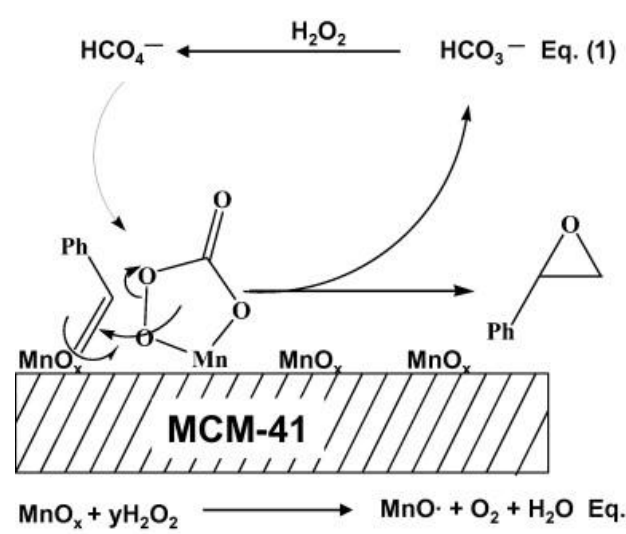
Figure 15. Possible reaction mechanism for the epoxidation of styrene on Mn-MCM-41. Reprinted from Ref. [132], Copyright 2014, with permission from Elsevier. Figure 16. Depiction for the diffusion of styrene inside the pore channels of different catalysts in epoxidation process: ( a ) 3Cu-MCM-41( d ), ( b ) 3CuO/AMS, ( c ) 3Cu-SBA-15(d), ( d ) 3CuO/SBA-15(p), ( e ) 3CuO/AMS(p). Table 2. Catalytic properties of different catalysts on styrene oxidation.